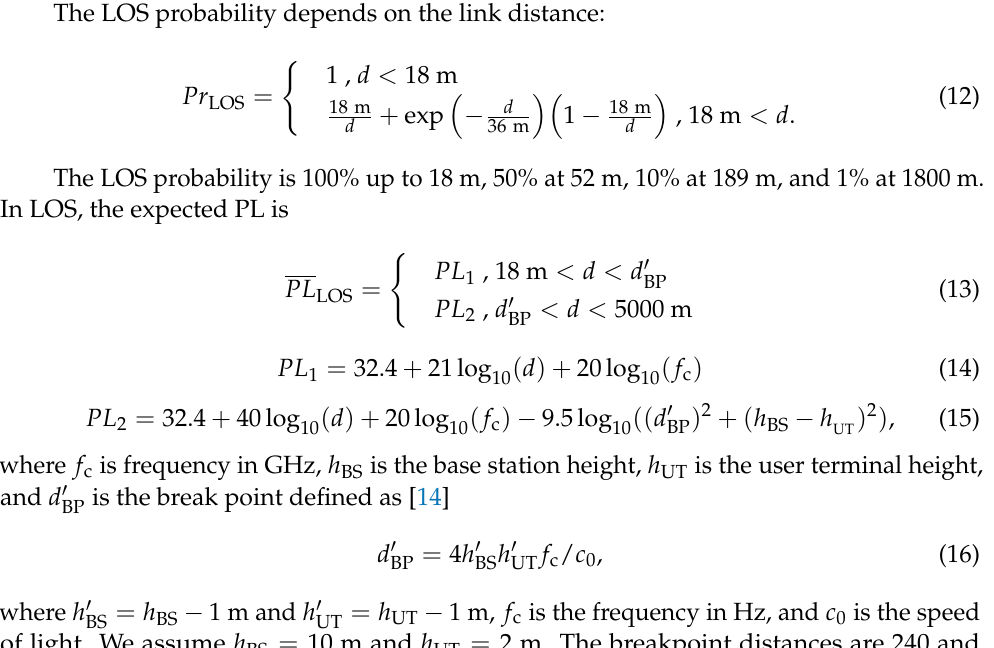
Figure 3. The OLS and MLE fitted models give the same expected PL at a link distance of about 37 m. Therefore, for most reasonable link distances the OLS model underestimates the expected PL, i.e., overestimates the link distance for a given PL. With MLE, the link distance corresponding to PL = PL ∗ is 100 m and with the OLS fitted model, it is about 170 m. The OLS fitted model predicts a significant probability of censored PL between 63 and 490 m ( PL ( d ) ± 1.96 σ